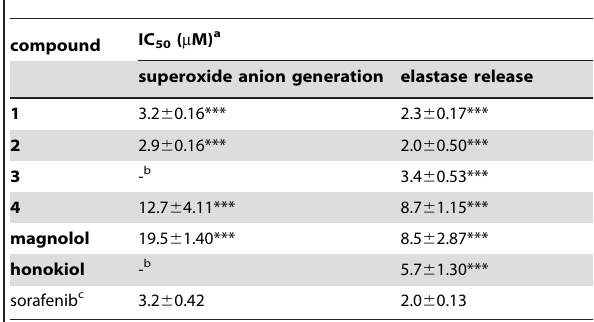
Table 2. Inhibitory effects of 1 – 4 on superoxide anion generation and elastase release by human neutrophils in response to FMLP/CB.